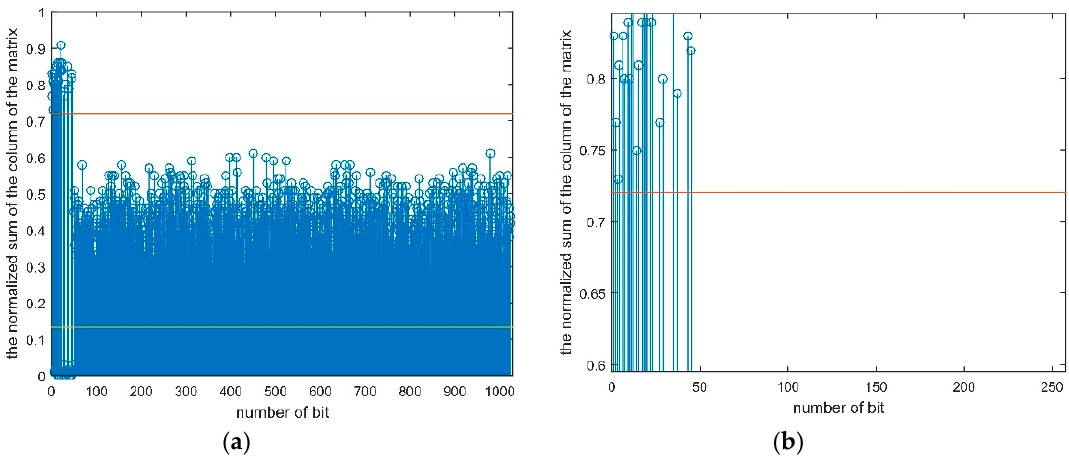
Figure 3. ( a ) This is the figure of Y sum * with BER = 0.08, α = 2.7. ( b ) This is the partial enlargement of Figure 3a at the frame header. There are no “1”s below the up threshold, indicating that all ”1”s are determined correctly.